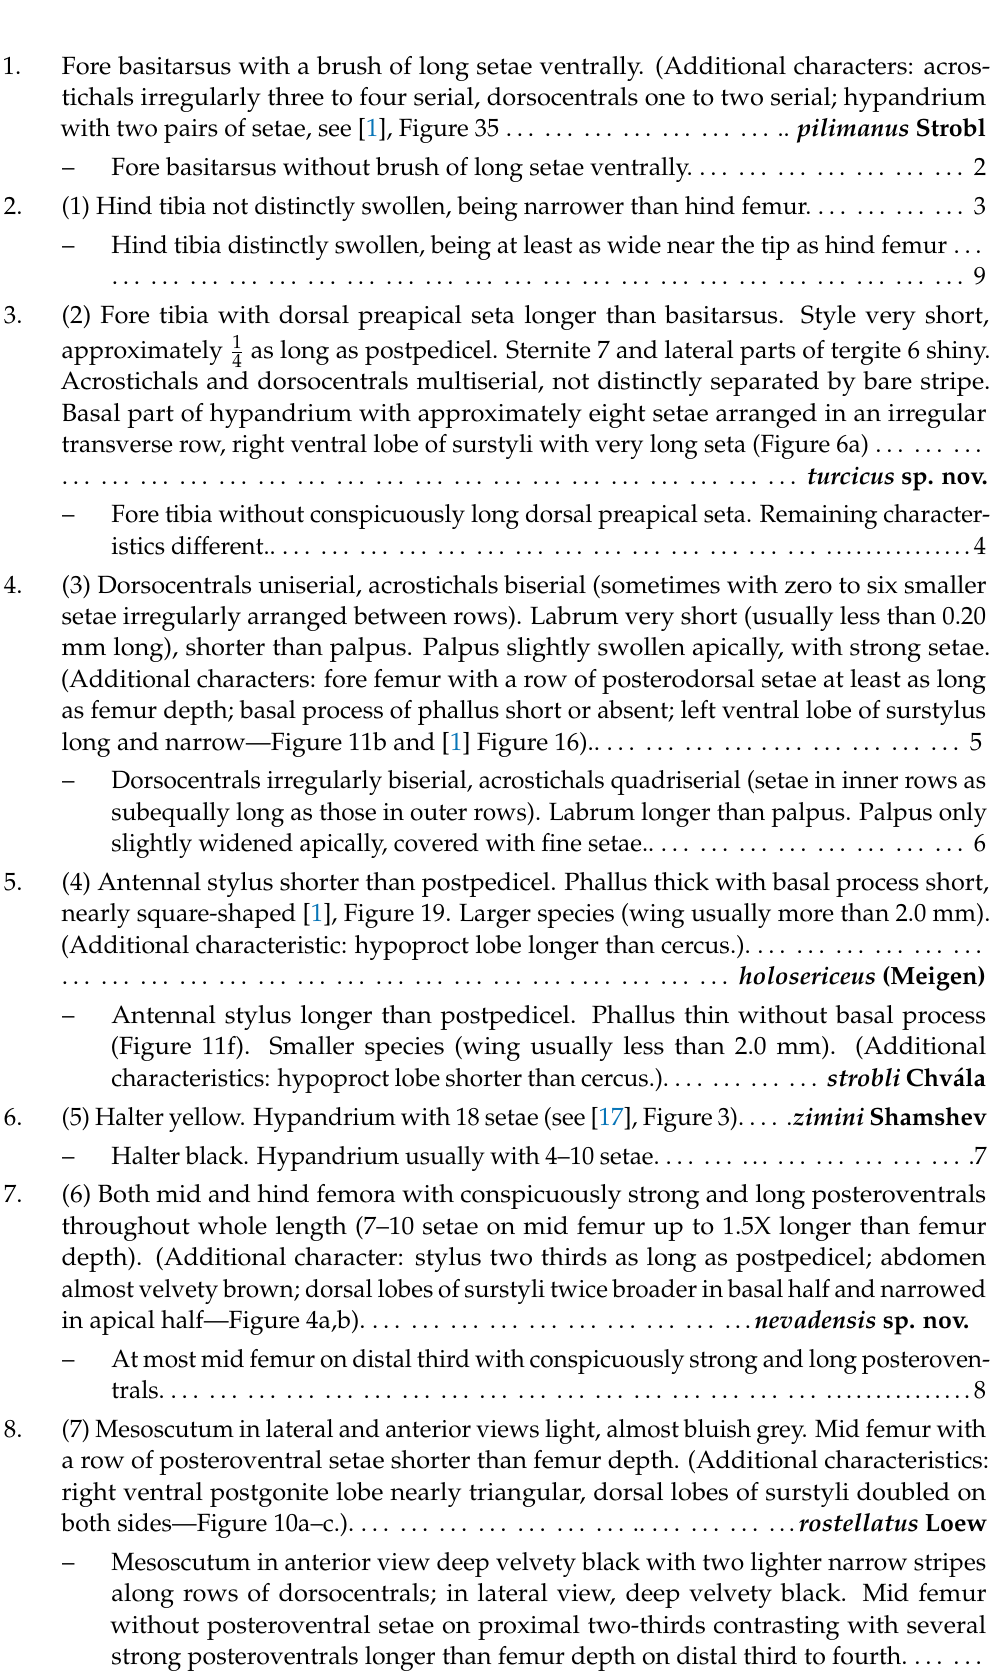
Fore basitarsus with a brush of long setae ventrally. (Additional characters: acros- tichals irregularly three to four serial, dorsocentrals one to two serial; hypandrium with two pairs of setae, see [1], Figure 35 . . . . . . . . . . . . . . . . . . . . . .. pilimanus Strobl